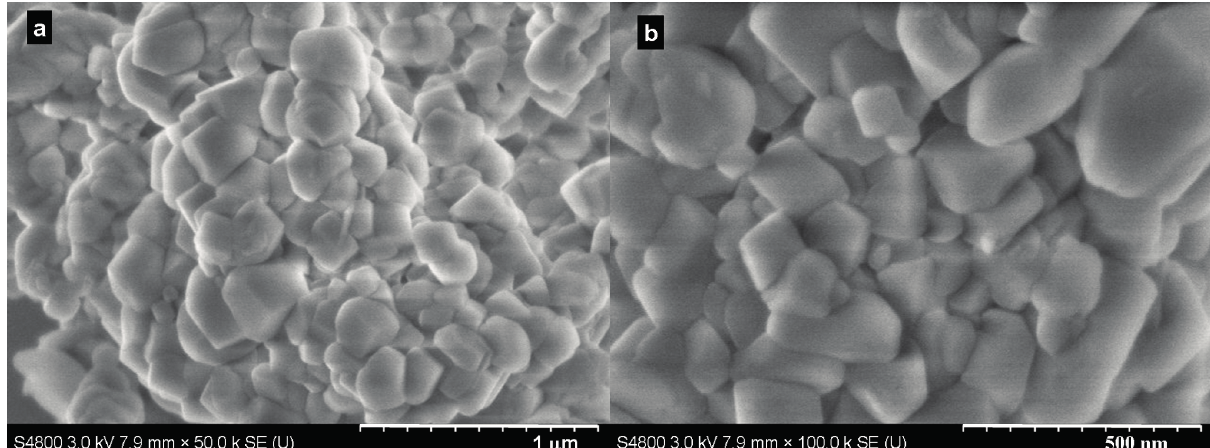
Figure 2. SEM (scanning electron microscope) images of samples produced at ( a ) 40.0 °C and ( b ) 60.0 °C with 0.1 MPa in 5